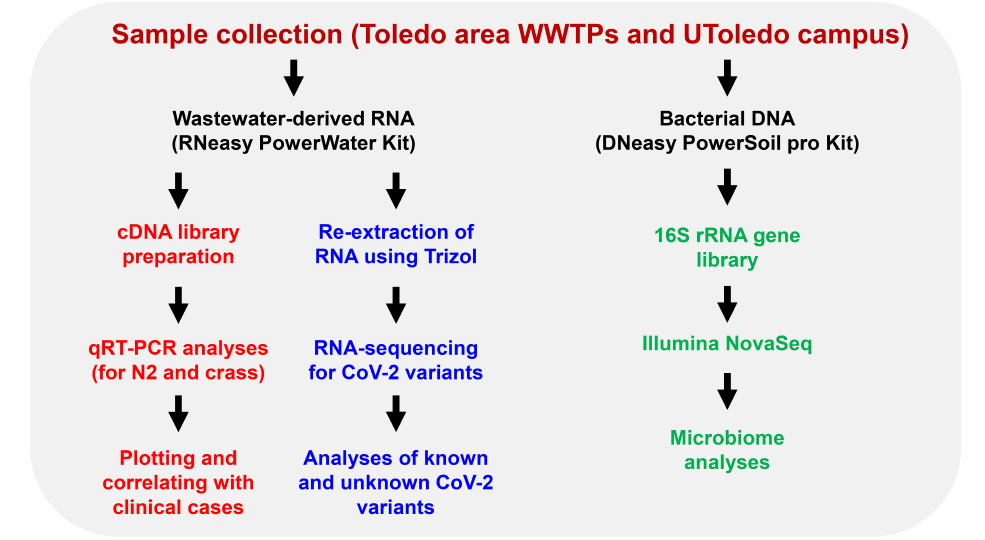
Figure 2. An overview of the Toledo area wastewater surveillance for COVID-19. Raw sewage samples were collected from Toledo area WWTPs and the UToledo campus and were used for RNA extraction. The RNA isolated from the wastewater samples were analyzed using qRT-PCR and the RNA was further analyzed by high-throughput sequencing for the identification of SARS-CoV-2 variants. The sewage samples were also used for microbiome analyses by extracting the bacterial genomic DNA, as